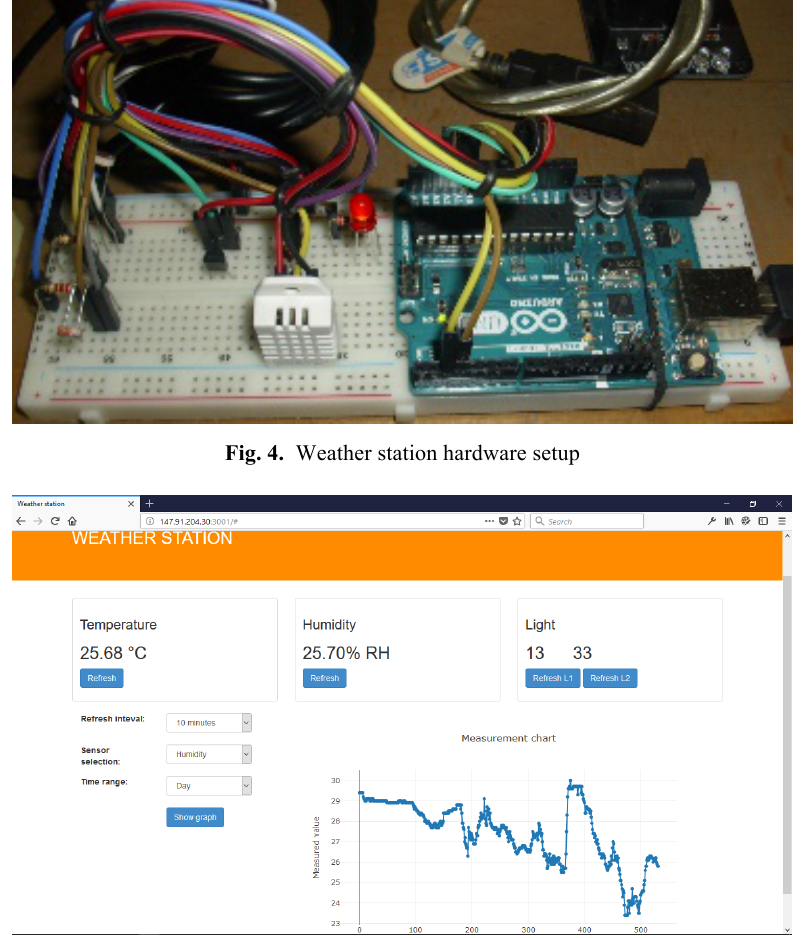
Fig. 5. Weather station web page